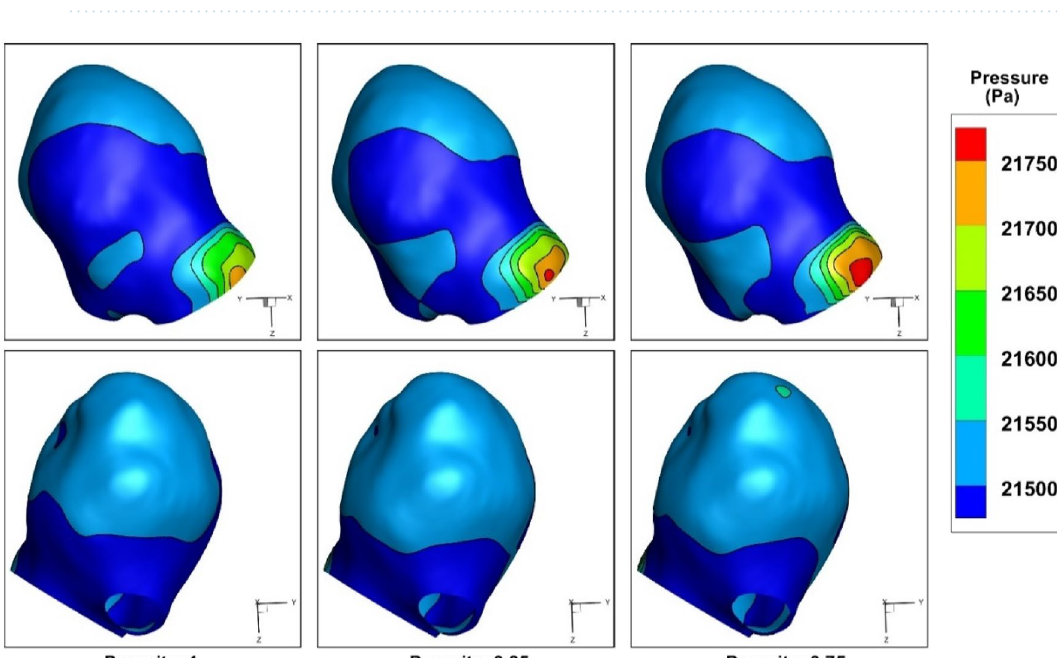
Figure 10. Effects of coiling porosity on pressure distribution at peak